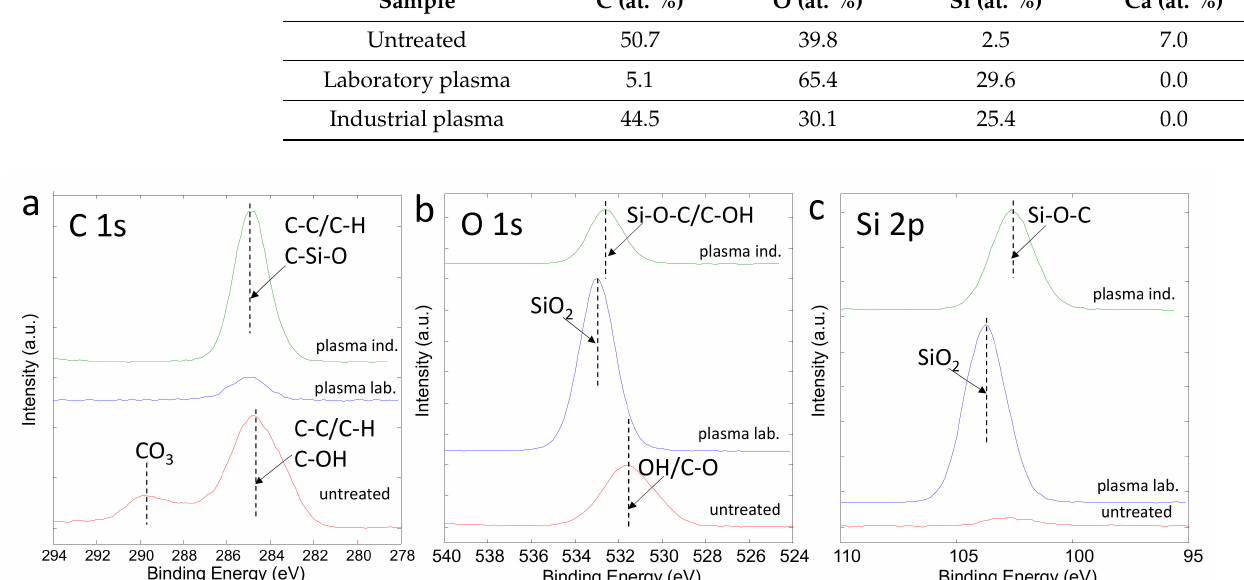
Figure 7. High energy resolution XPS spectra C 1s ( a ), O 1s ( b ), and Si 2p ( c ) from untreated (read line), laboratory plasma (blue line), and industrial plasma (green line) treated